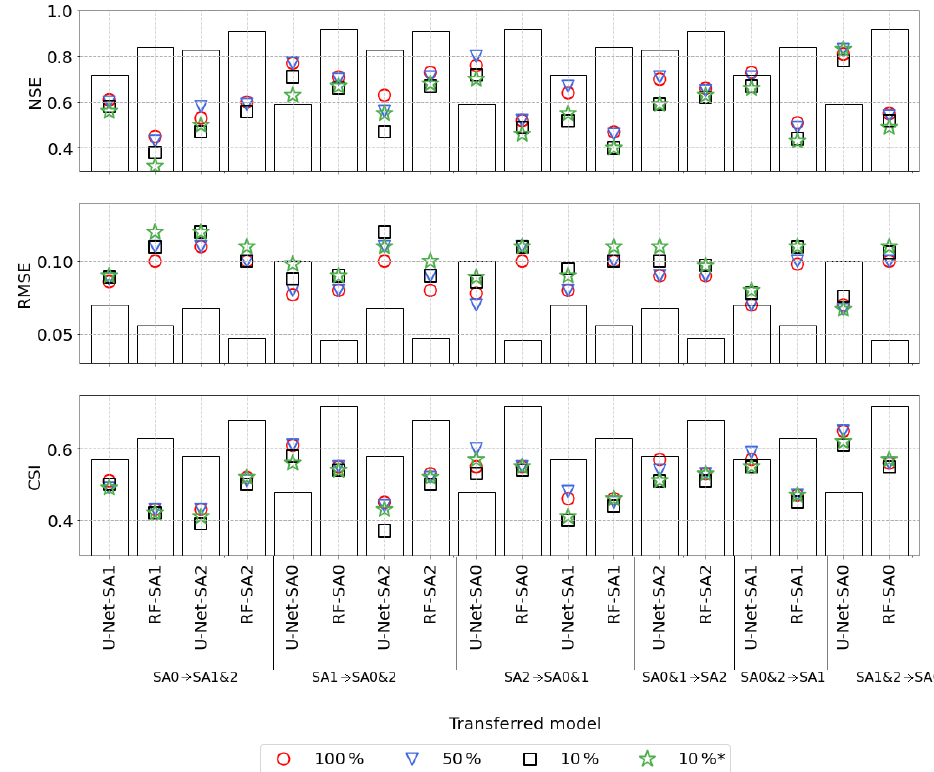
Figure 5. Evaluation of transfer learning: the colored markers represent the performance indices for transferred models with different per- centages of data from the domain where the model has been transferred to. For example, SA0 → SA1&2 refers to a model pre-trained on SA0 and then transferred to (re-trained on) SA1 and SA2. The bars show the performance indices for the models trained exclusively on the transfer target domains. 10% ∗ denotes that the training data from the transferred domain was generated using only two precipitation events (40 and 120mm). The transferred U-Net-SA1&2 → SA0 (pre-trained model SA1&2 and transfer target SA0) models outperformed the U-Net-SA0 model, but the RF-SA0 model was superior to the transferred RF-SA1&2 → SA0 models for all percentages used of new training data from